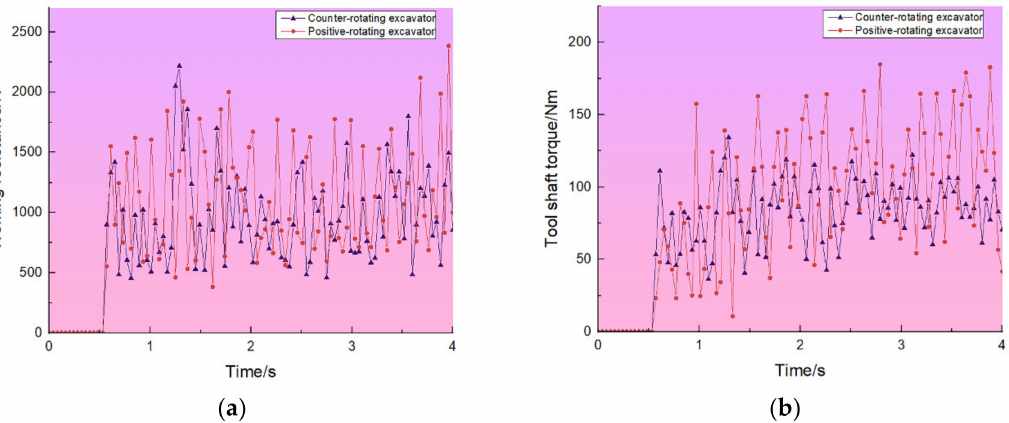
Figure 20. The response surface of each test factor to tool shaft torque. ( a ) Results of comparative analysis of working resistance. ( b ) Results of comparative analysis of tool shaft